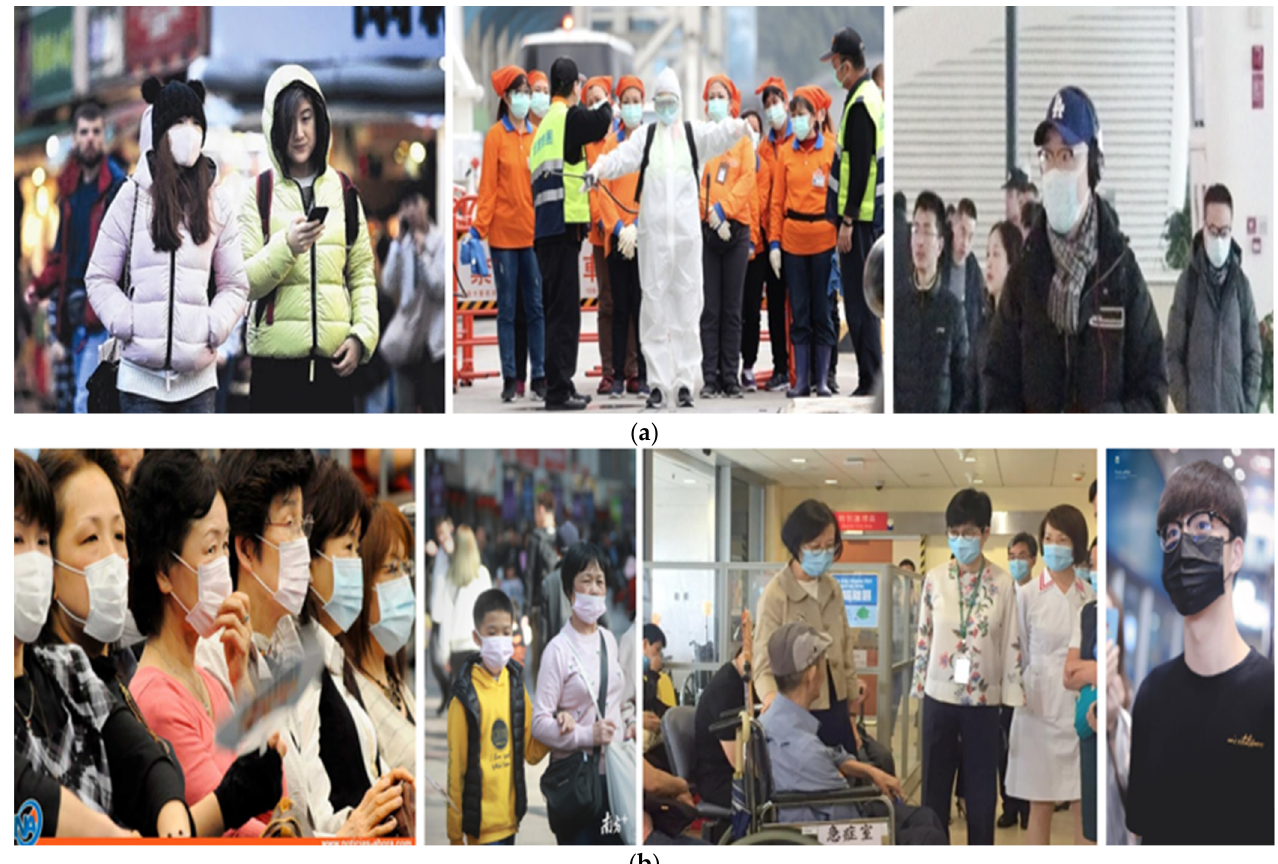
Figure 3. Sample of dataset in the experiment. ( a ) Face Mask Dataset (FMD) and ( b ) Medical Mask Dataset (MMD).